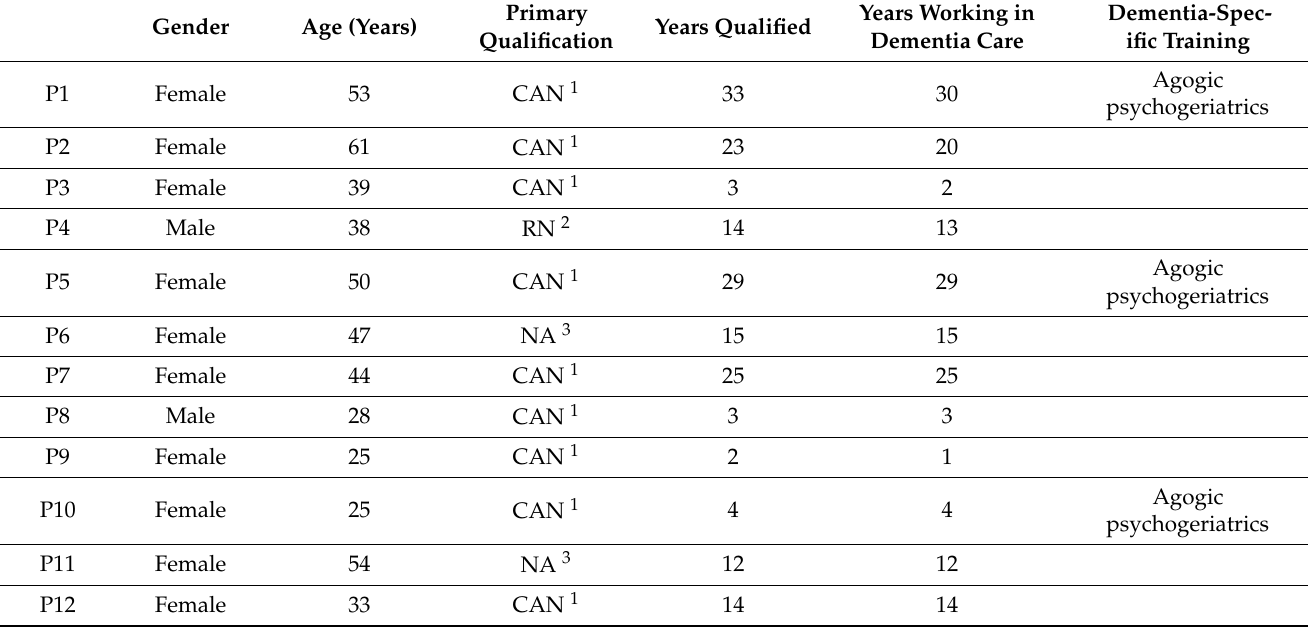
Table 2. Background characteristics of the